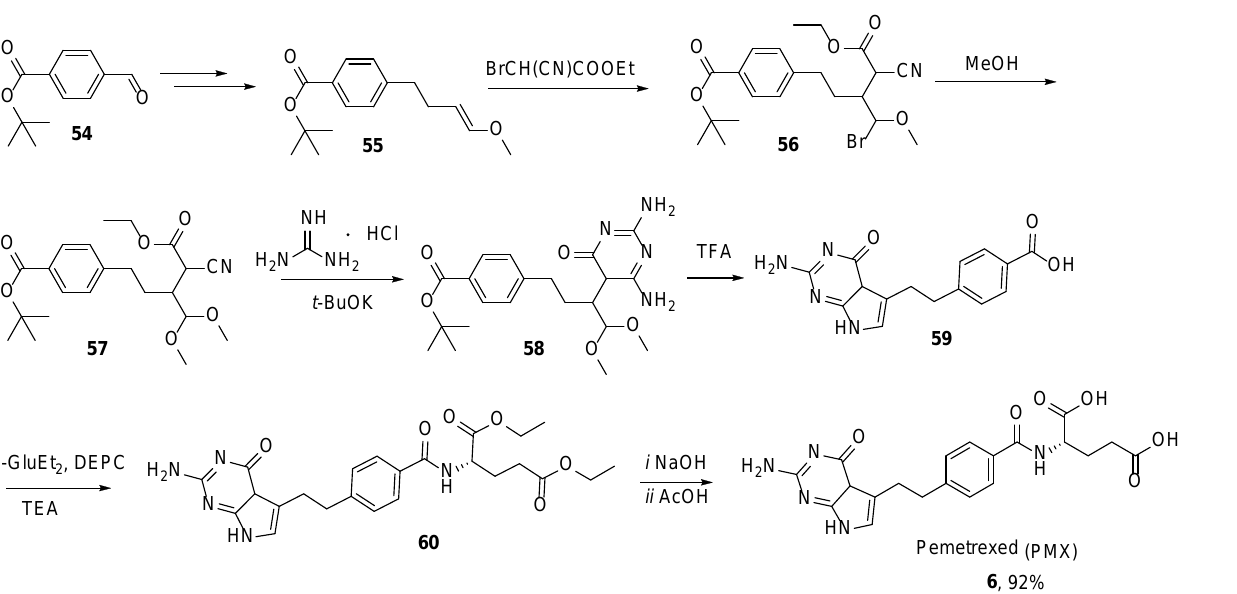
Scheme 22. Multistep synthesis of Pemetrexed starting from tert -butyl-4-formylbenzoate 54 .